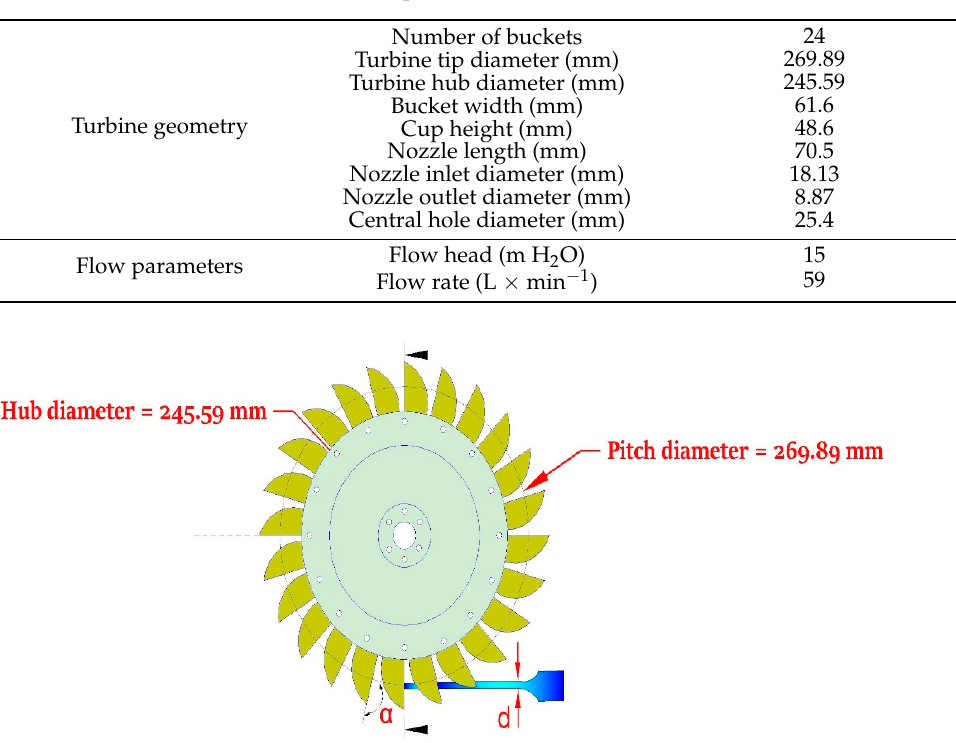
Table 1. Geometric dimensions and flow parameters of the Pelton turbine.